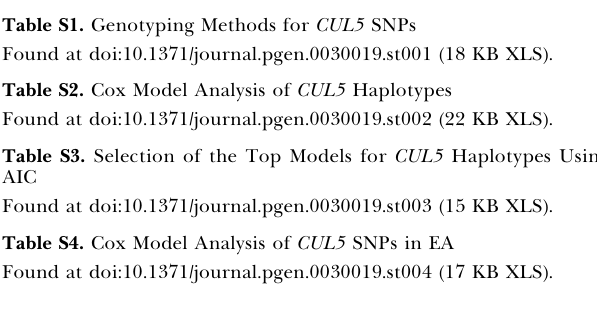
Table S1. Genotyping Methods for CUL5 SNPs Table S2. Cox Model Analysis of CUL5 Haplotypes Table S3. Selection of the Top Models for CUL5 Haplotypes Using AIC Table S4. Cox Model Analysis of CUL5 SNPs in